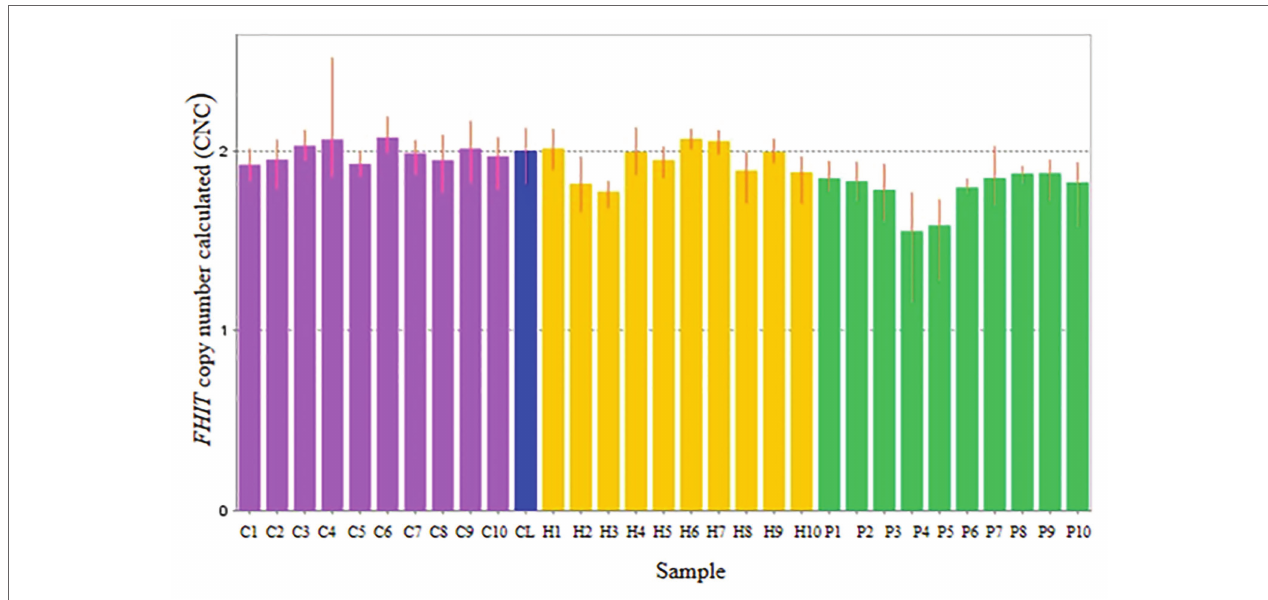
FIGURE 5 | Representative of copy number calculated (CNC) of FHIT in normal control (purple bars), non-cleft with hypodontia (yellow bars) NSCL/P with hypodontia (green bars) and calibrator (blue bar).